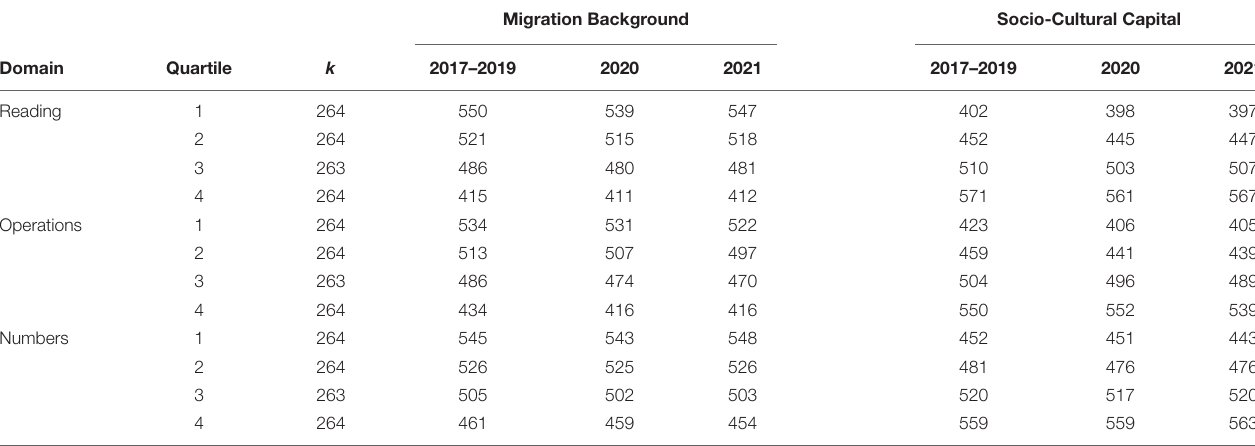
TABLE 6 | Average school scores for each quartile of the proportion of students with migration background and for each quartile of the schools’ mean socio-cultural capital (see Figure 3 ). Migration